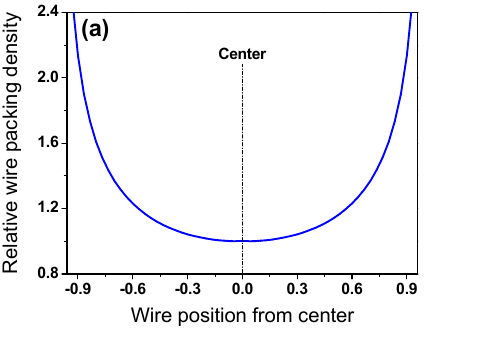
Figure 3. ( a ) Relative wire packing density along TD wr and ( b ) comparison of wire packing density as a function of ring pitch during Stelmor cooling.